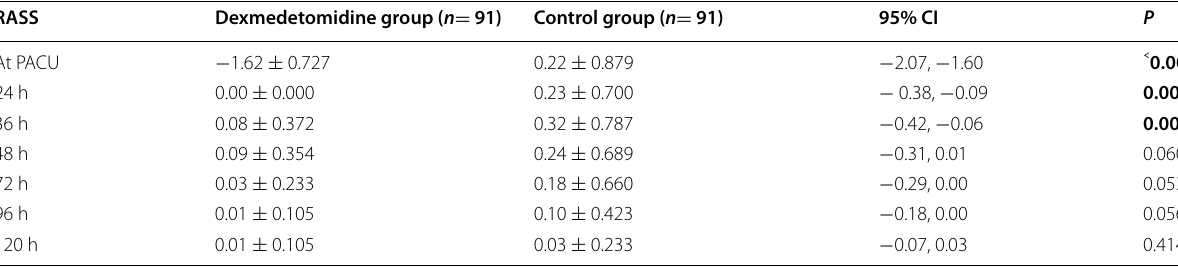
Table 2 Postoperative RASS score follow‑up in the studied